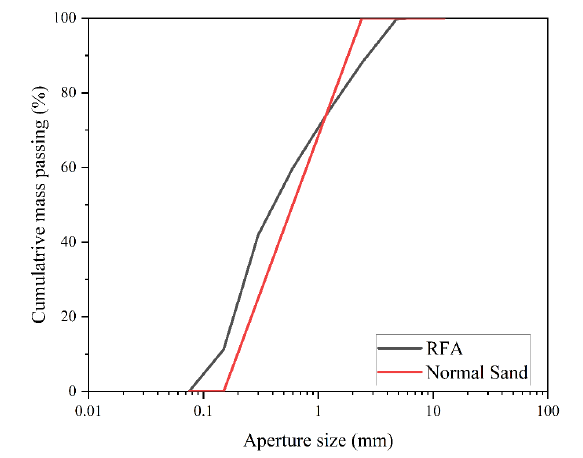
Figure 2. Particle size distribution of RFA and normal sand.